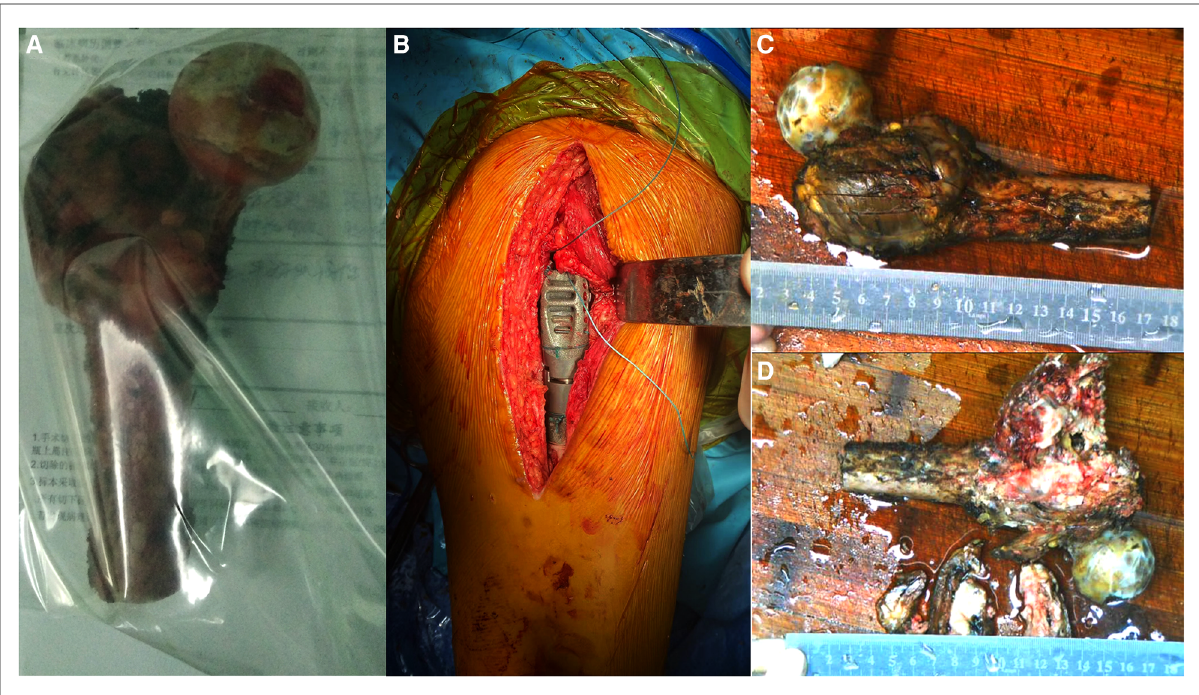
FIGURE 2 Intraoperative imaging and postoperative gross specimen. ( A,B ) The proximal femur is completely resected, and the tumor prosthesis is successfully implanted. ( C ) The gross specimen shows an uneven mass in the trochanter of the femur, with a size of approximately 6.0 cm×6.0 cm×4.0 cm. ( D ) The section of the specimen shows that the center of the mass is gray-white, with bleeding and necrotic areas invading the bone